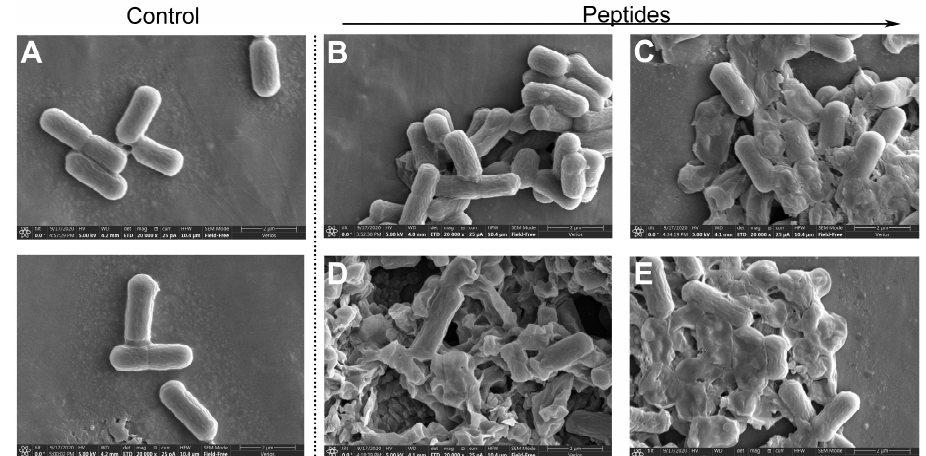
Figure 6. Morphological changes of S. mutans exposed to ( B ) GHaR6R, ( C ) GHaR7R, ( D ) GHaR8R, and ( E ) GHaR9W with a concentration of 25 µ M. The bacteria were treated with PBS served as ( A ) the negative control. SEM magnification, × 20,000. The scale was 2 µ m.